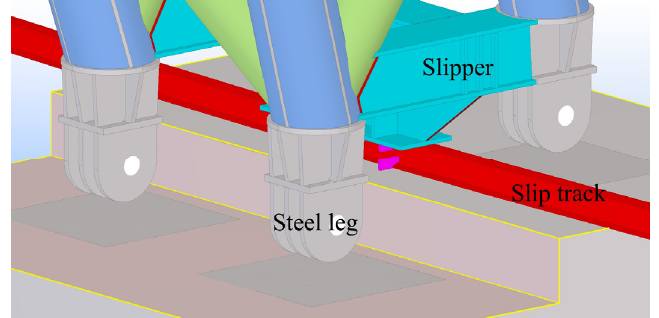
Figure 7. Unloading of steel structure in the main gymnasium.